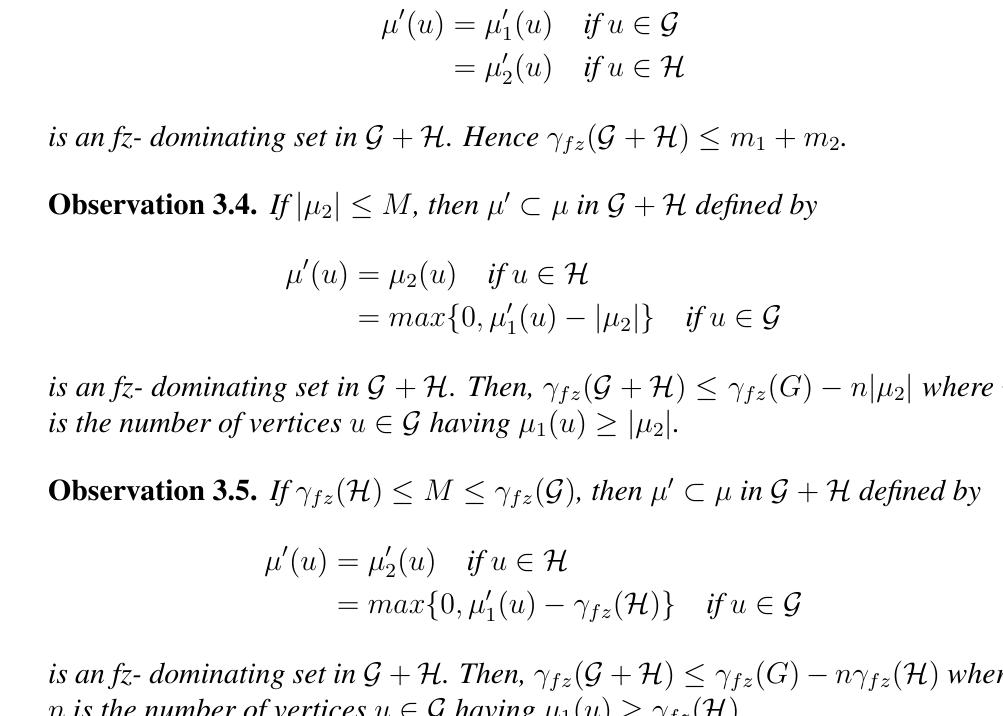
+ G , G and G 1 2 1